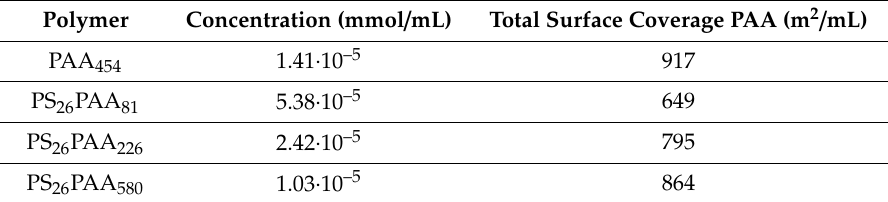
Figure 4. Schematic visualization of single chain adsorption on a nanotube surface. Table 1. Total surface coverage of single polymer PAA chain for di ff erent polymers at 0.46 mg / mL concentration in water at pH